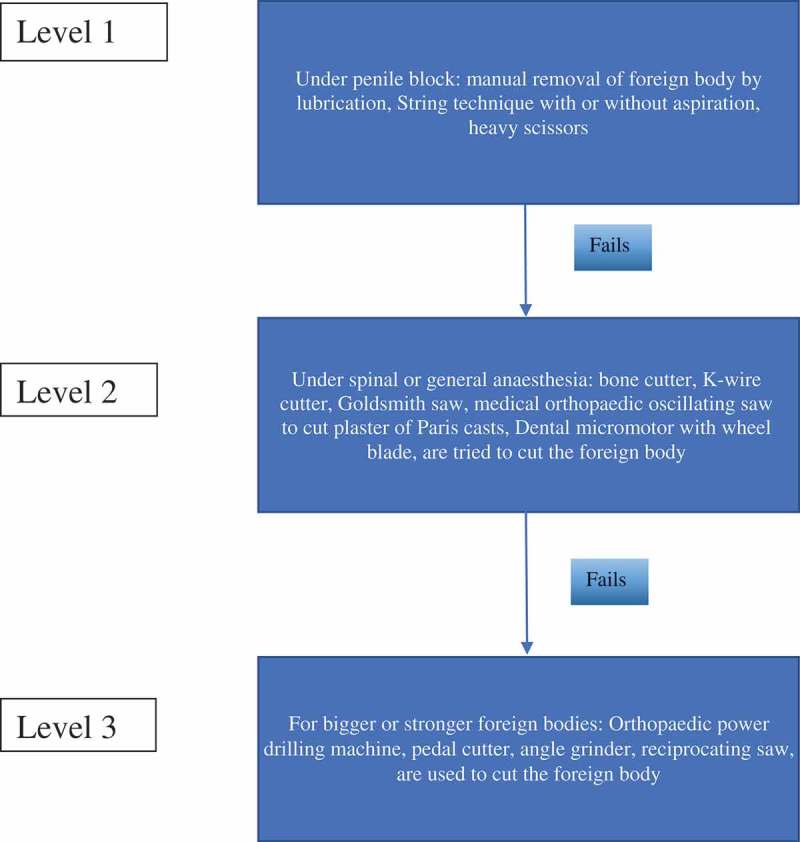
Stepwise approach.